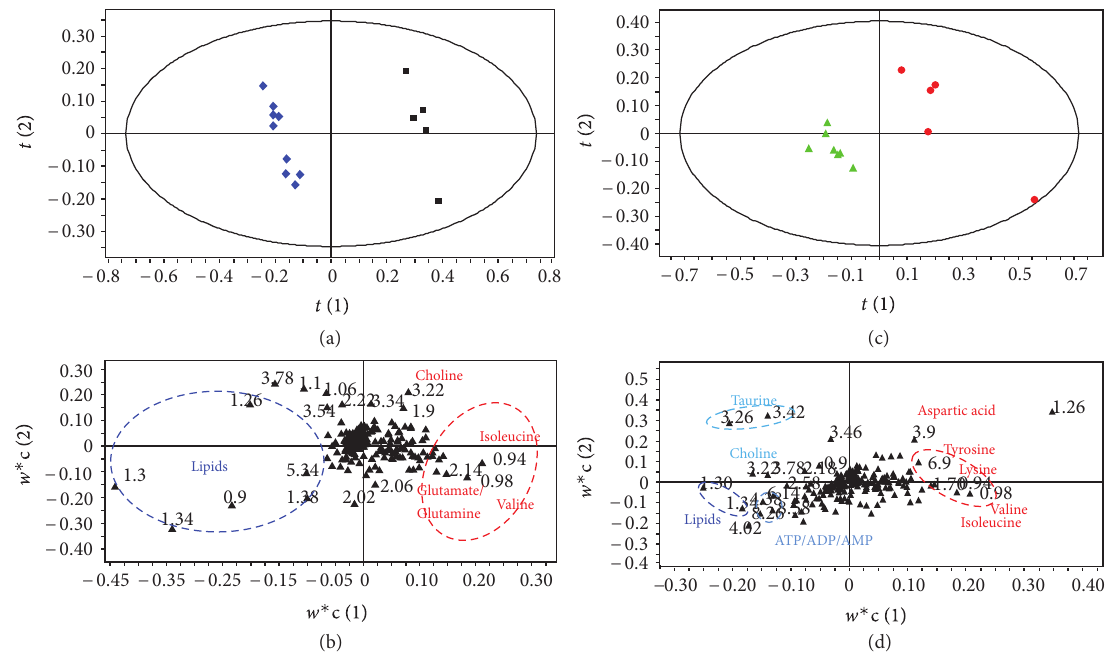
F4:PLS-DA(a)scoreplotand(b)loadingplotbasedonthe on the HNMR spectra of bone marrow samples from nonexposed (green triangle,